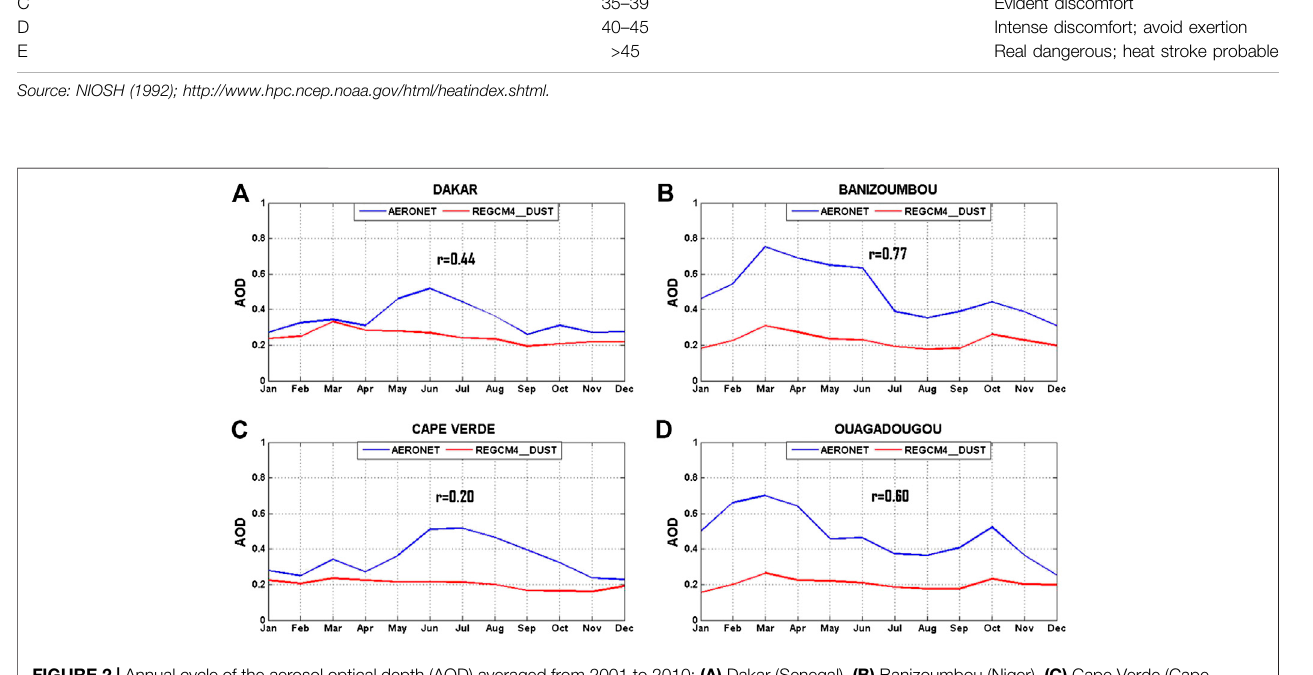
FIGURE 2 | Annual cycle of the aerosol optical depth (AOD) averaged from 2001 to 2010: (A) Dakar (Senegal), (B) Banizoumbou (Niger), (C) Cape Verde (Cape Verde), and (D) Ouagadougou (Burkina Faso) for the AERONET data and the RegCM4_DUST model.